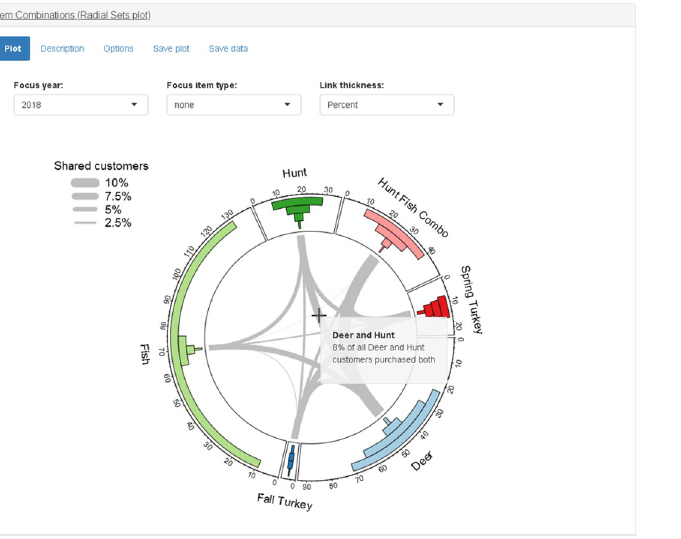
Fig 9. Screenshot of item combinations (Radial Sets plot)